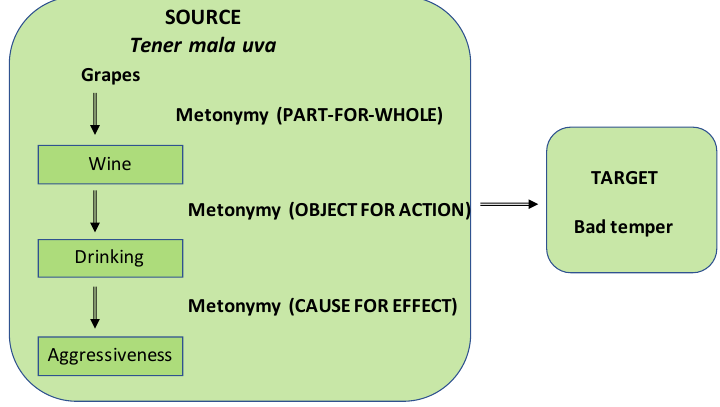
Figure 5. Metonymic chain underlying the interpretation of tener mala uva.